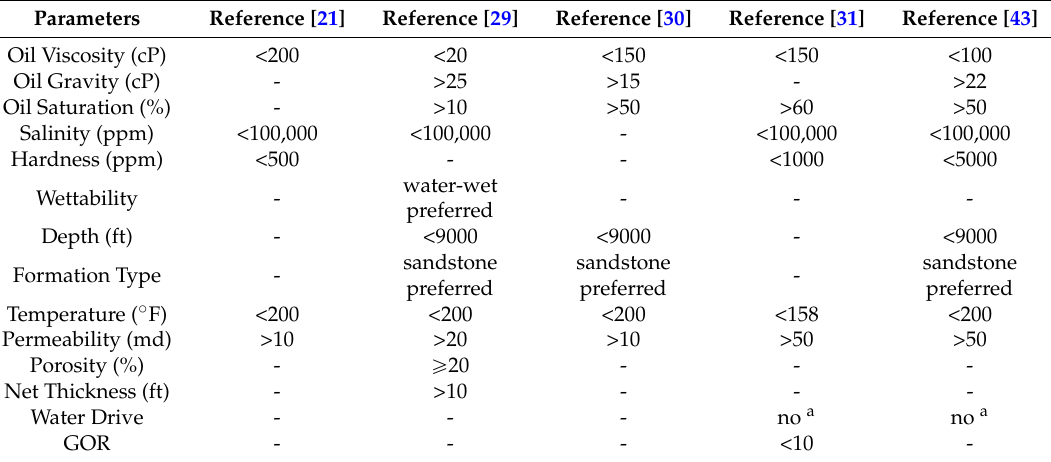
Table 6. Previously-suggested screening criteria for the polymer